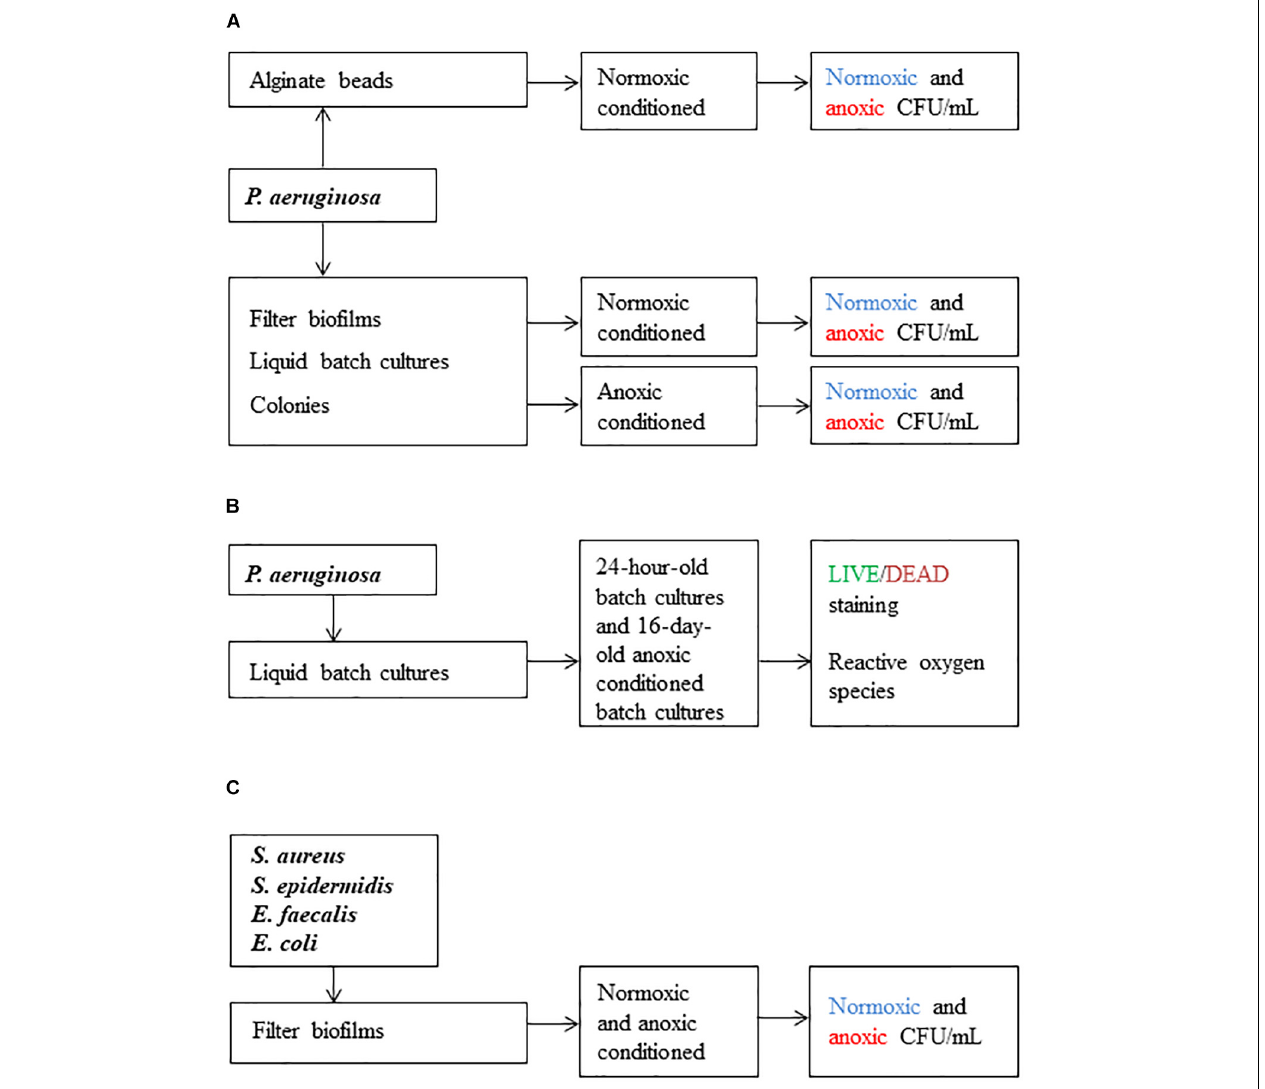
FIGURE 1 | Scheme of the workflow used in this study. Methods applied in (A) were used to investigate difficult-to-culture (DTC) subpopulations. Methods applied in (B) were used to determine viable but-non-culturable (VBNC) subpopulations and the effect of reactive oxygen species (ROS). Methods applied in (C) were used to investigate if other pathogens were sensitive to anoxic conditioning. Colony forming units per milliliter (CFU/mL) was the main outcome.